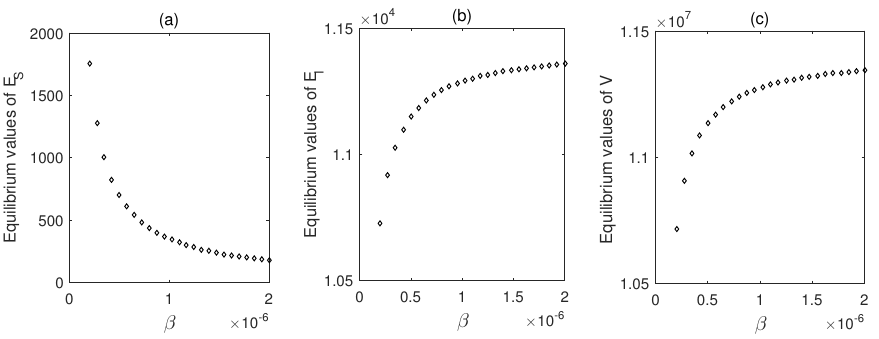
Figure 5. ( a – c ) Steady-state values of the populations plotted as function of β . Parameter values are same as in Figure 4.